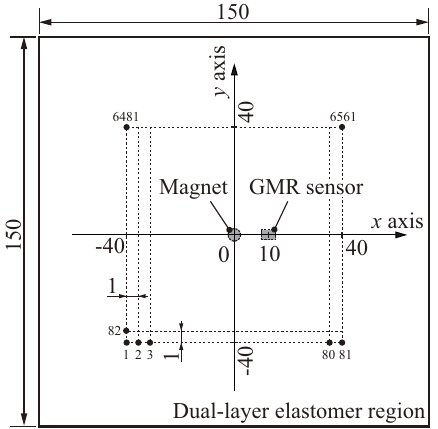
Figure 8. Measurement region and positions of the spatial response. The black dots indicate the center position of the applied load, i.e., the center of the indenter. The indenter was moved from ( x , y ) = ( − 40,40 ) to ( 40,40 ) in 1 mm steps based on the index numbers 1, 2, ..., 6,561 of the